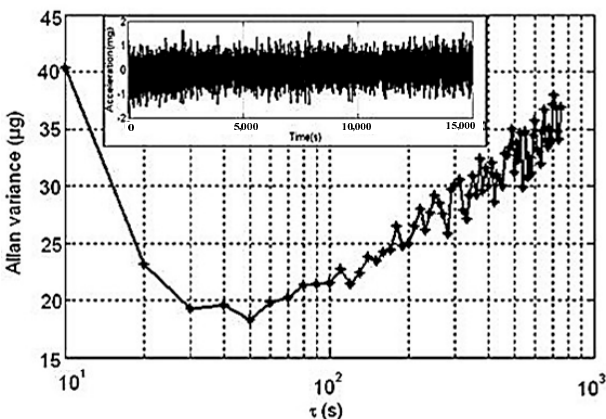
Figure 10. Allan deviation plot of accelerometer.